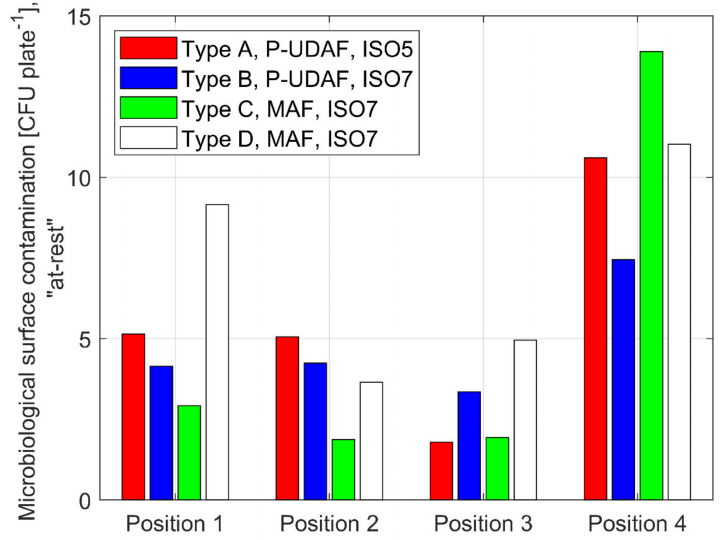
Figure 6. Average microbiological surface contamination in di ff erent OT locations under “at rest” conditions after cleaning procedures. Position 1 = surgical table, Position 2 = scialytic lamp, Position 3 = surgical instruments table, Position 4 = anesthesia